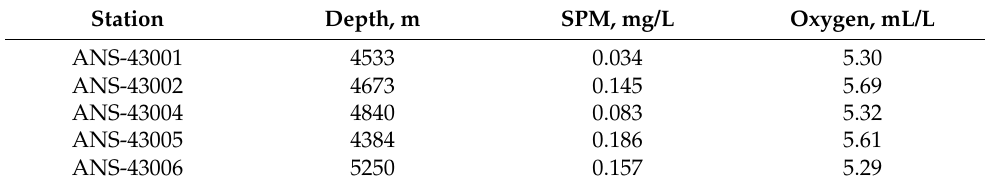
Table 4. Suspended particulate matter (SPM) concentration and oxygen in the near-bottom waters in Discovery Gap.